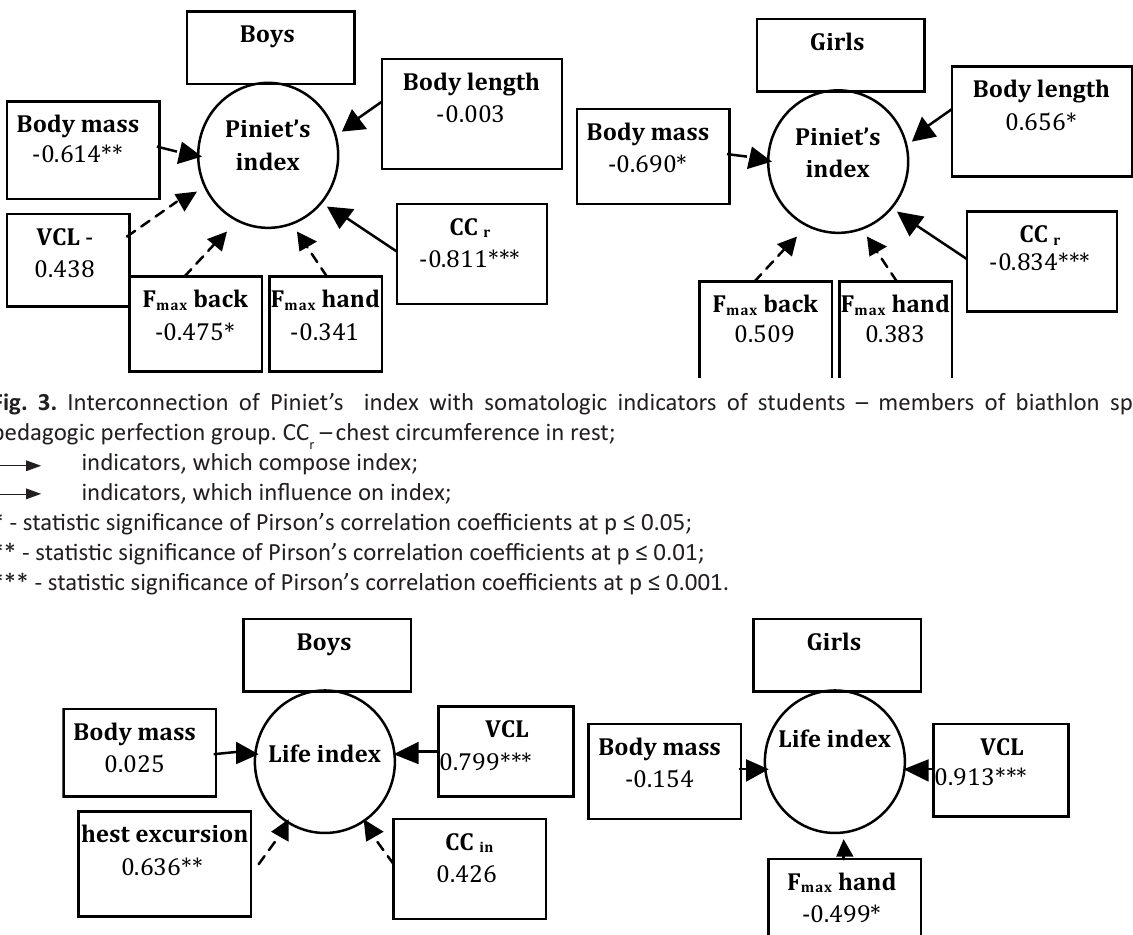
- chest circumference at inhale; CC in